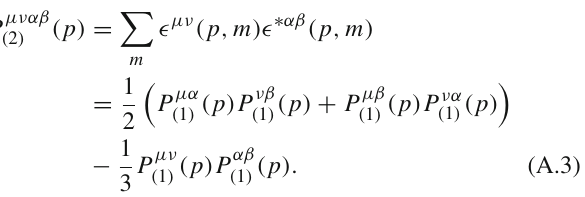
Table 6 Spin factors for different decay chains leading to B → P 1 P 2 P 3 γ . The letters S, P, V, A refer to scalar, pseudoscalar, vector and axial-vector particles, respectively. T + and T − are tensor particles Decay chain Spin